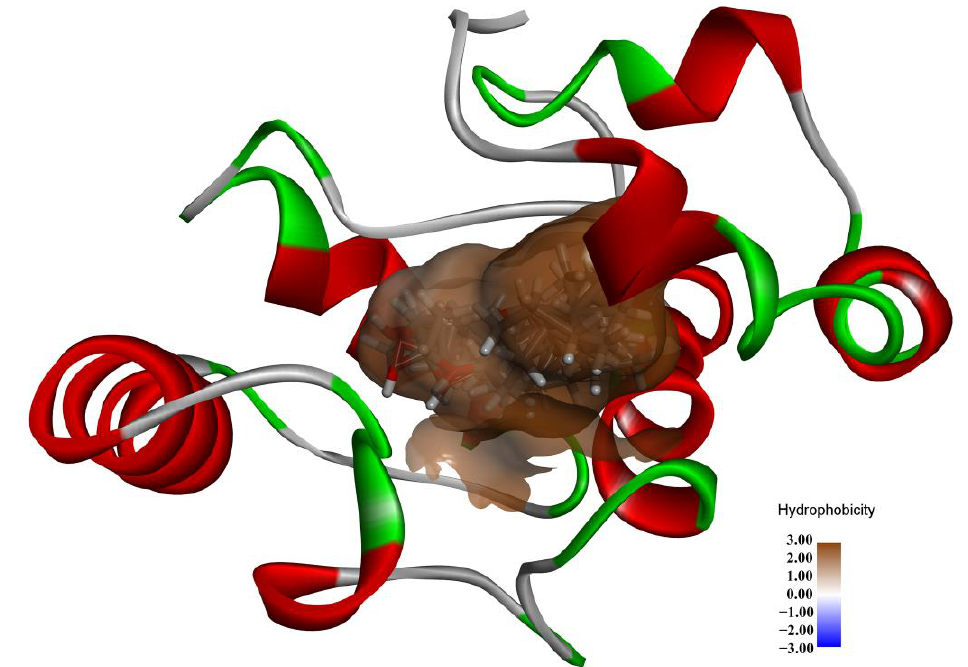
Figure 8. The hydrophobic cavities of Z3D (ten representations) anchored in SnocOBP9 displayed in surface view. Table 4. Cluster analysis of the SnocOBP9-Z3D complex based on the trajectory of MD simulations.